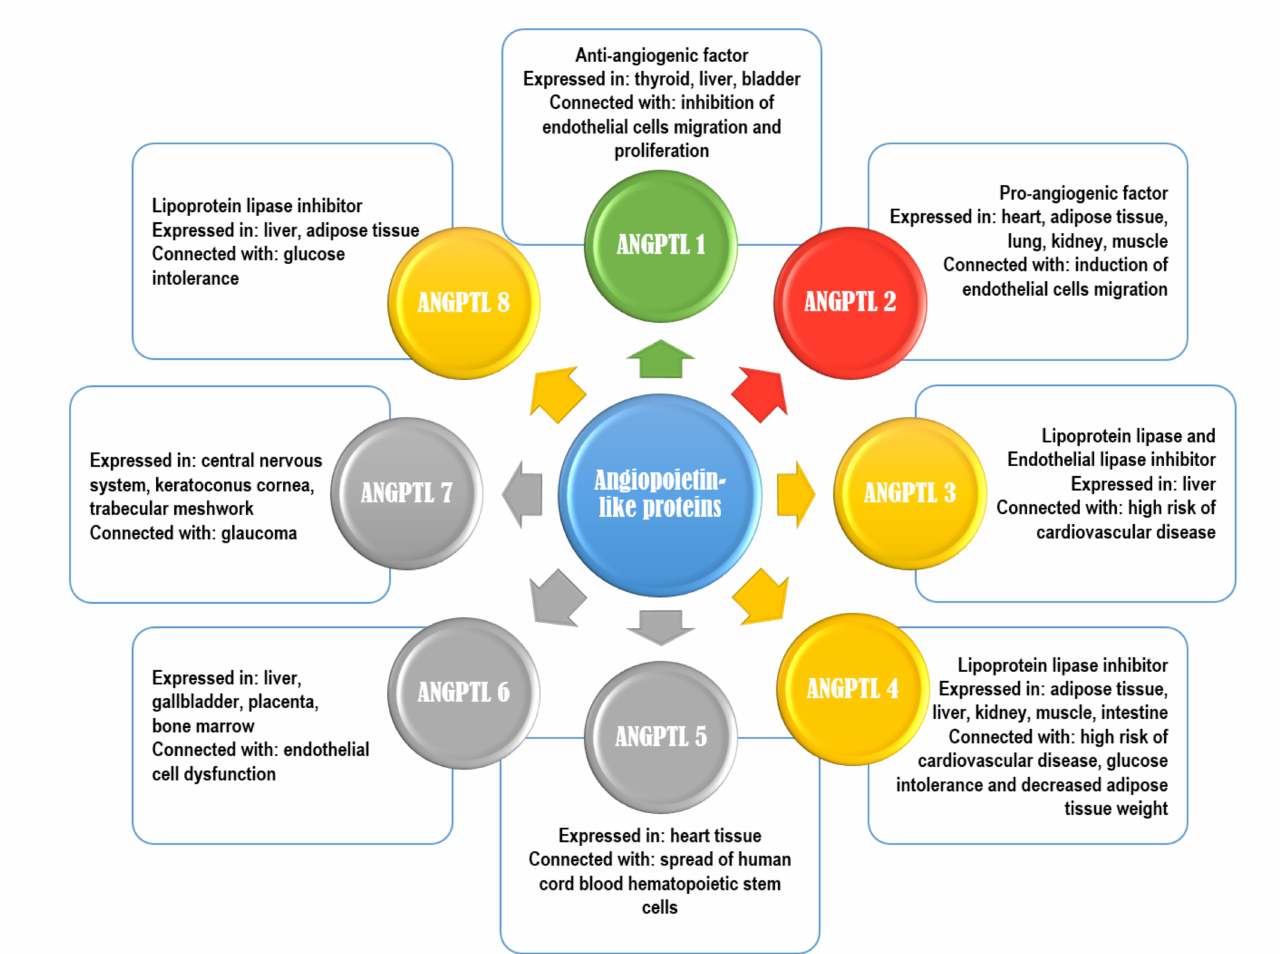
Figure 1. Characteristics of angiopoietin-like proteins. Green color-anti-angiogenic properties; red color-pro-angiogenic properties; yellow color-inhibitor of lipoprotein lipase; grey color-no specific